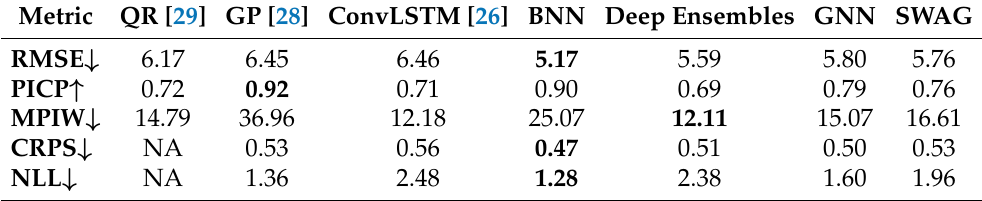
Table 8. Comparison of the previous works and the proposed models when quantifying uncertainty in data-driven forecast of air